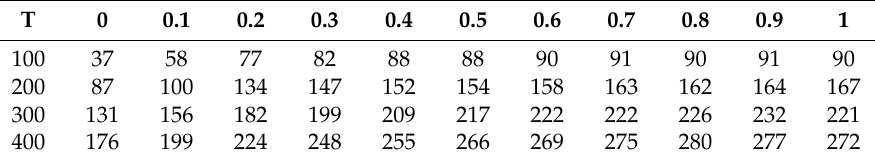
Table 3. Effects of parameter λ on the performance of the FDP based on the SC_net